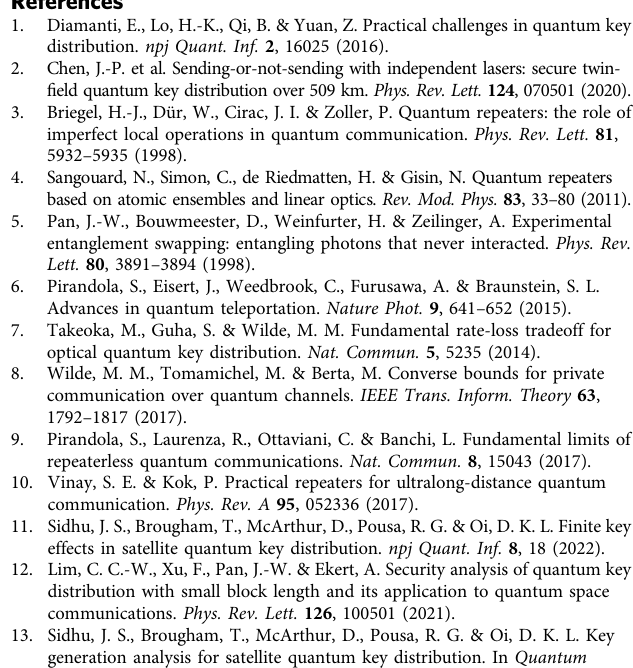
tions in Table 2. For details of the calculations and additional results